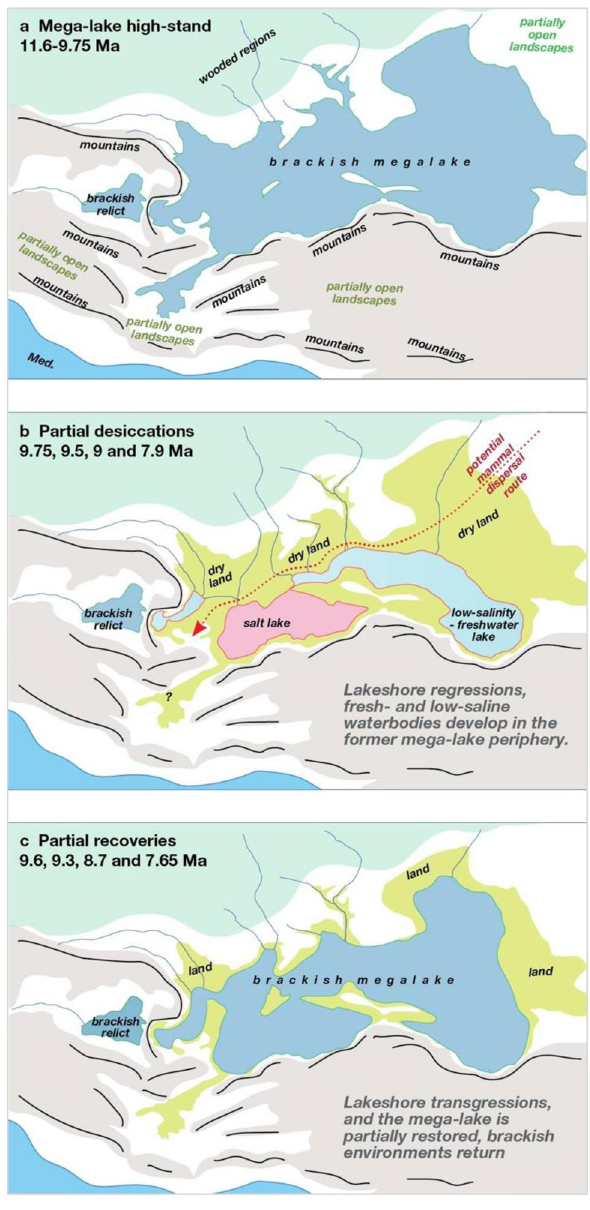
Figure 5. Schematic paleogeographic maps of lake regressions and landscapes of inner Eurasia. Dark green shading represents closed (forest) landscapes, light green shading shows former lake regions transformed to semi-open landscapes and brown shading indicate mountainous regions. Red dotted line indicates potential mammal dispersal routes across dry land and landbridges during lake-level regressions. ( a ) Paratethys megalake during high-stand configuration, ( b ) water distribution during the maximum lake regression. Note that a significant stretch of semi-open landscapes formed in the northern peripheral regions of the former megalake, providing potential passageways for mammal dispersals. ( c ) Paratethys during the partial water level recovery episodes, pushing back open